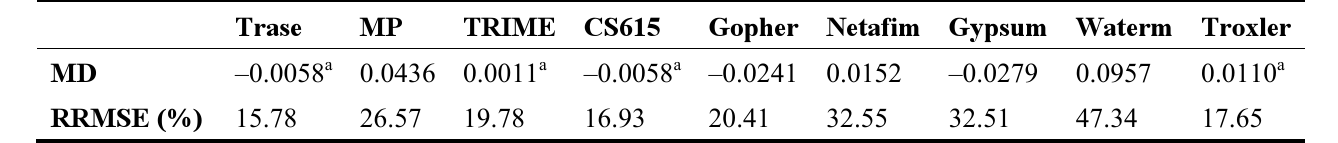
Table 1. MD and RRMSE of different soil water measuring